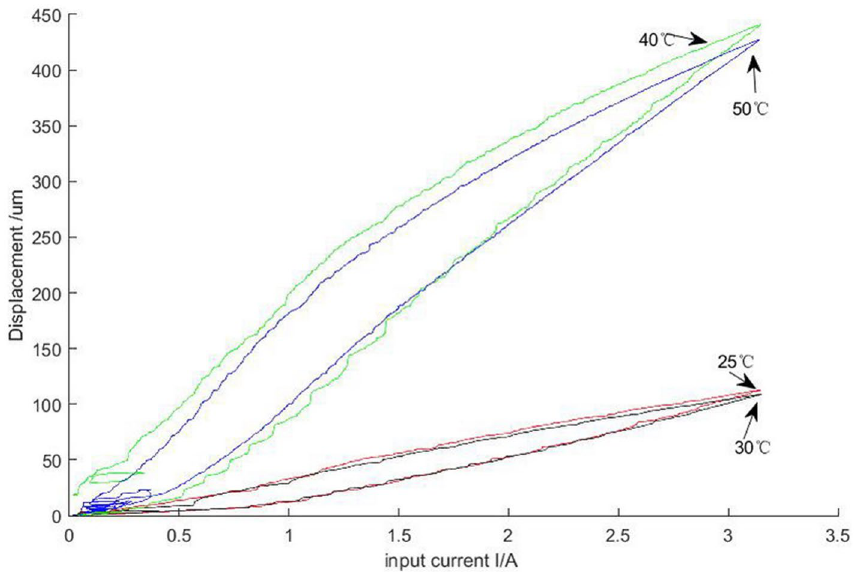
Figure 14. The radial bending deformation of GMM smart component vared with currents under various temperature cooling water.